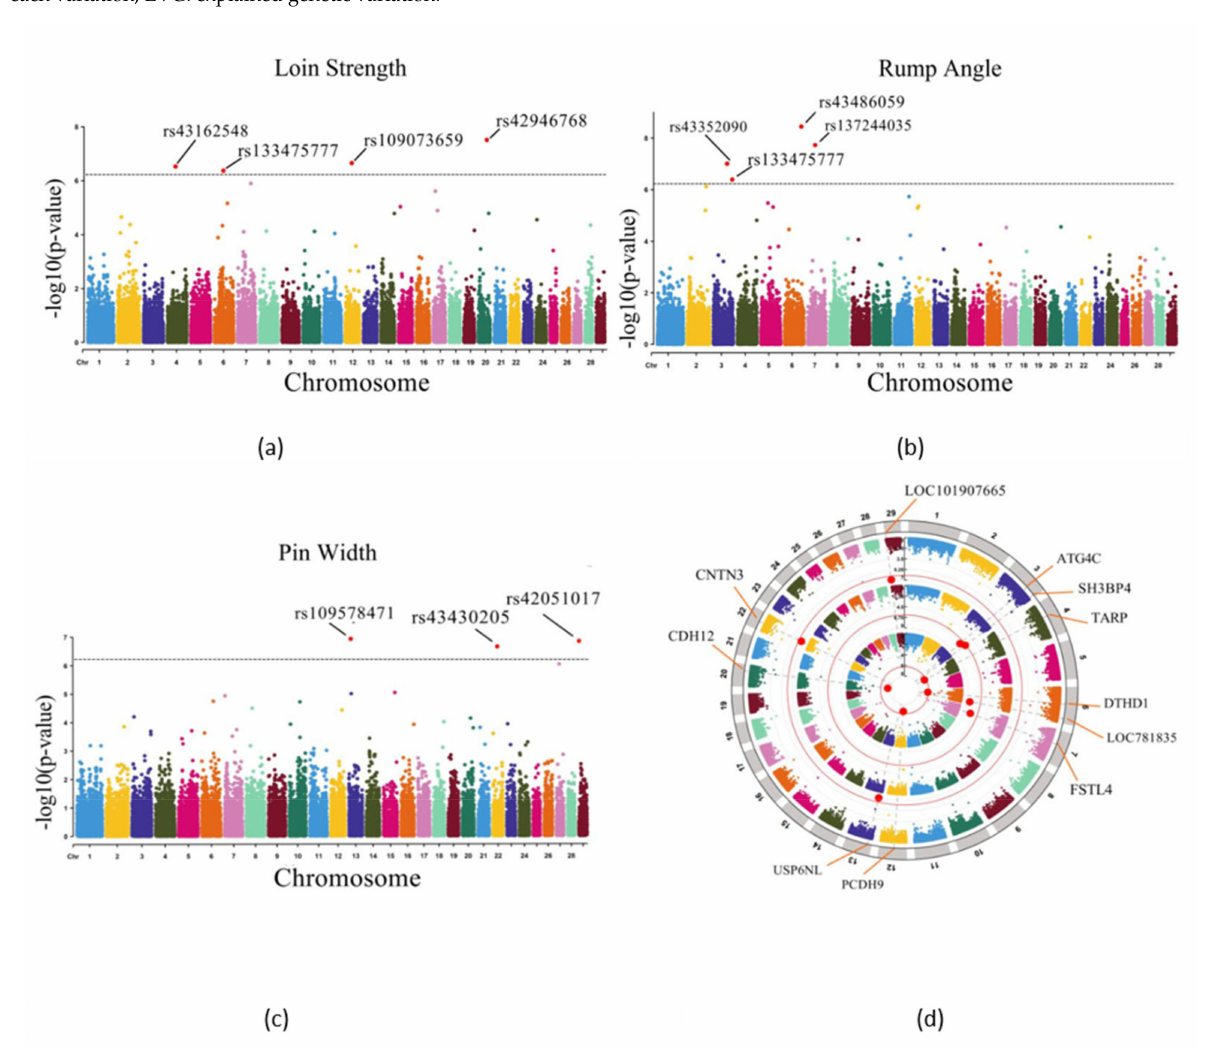
Figure 6. Manhattan plots of the LS ( a ), RA ( b ), and PW ( c ) drawn by the observed p -Value of each SNP and the location of the gene closest to each significant SNP of the three traits in the Manhattan plots ( d ). The gray horizontal lines in the Manhattan plots are significance thresholds (5.90 × 10 − 7 ); the red dots are SNPs that exceeded the